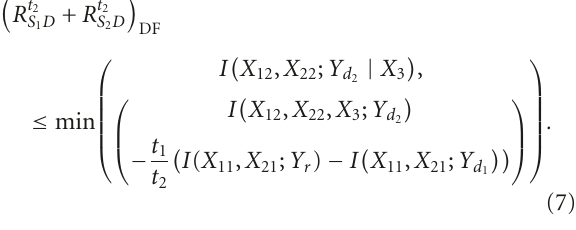
in the t 2 time slot at the sum-rate inherited from the DF rate region in (4)